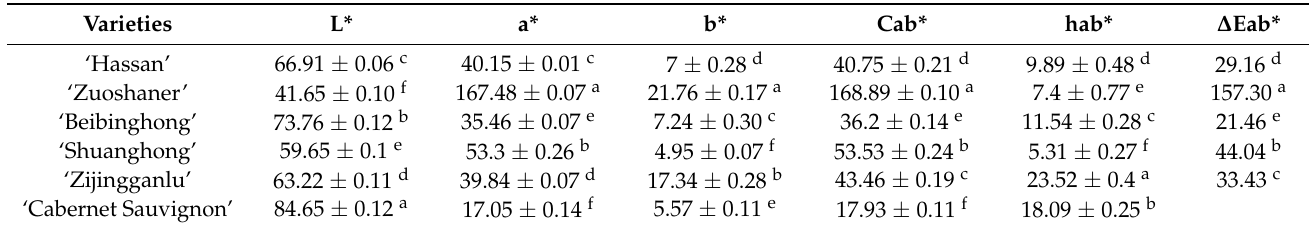
Table 3. Analysis of color differences in different varieties of wine.